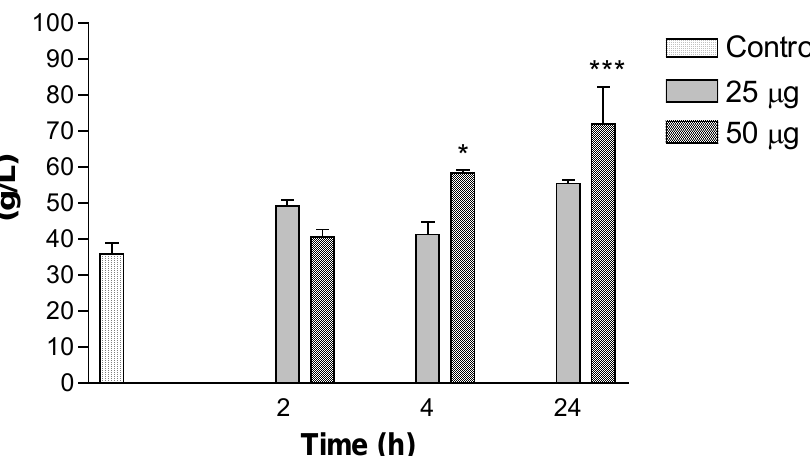
Figure 4. Variations in total protein levels in mice intraperitoneally injected with 25 or 50 μ g of Bothrops jararacussu venom diluted with 0.1ml PBS. Each bar represents the mean and vertical lines, the standard error of mean (S.E.M.) of results obtained from 6 animals.